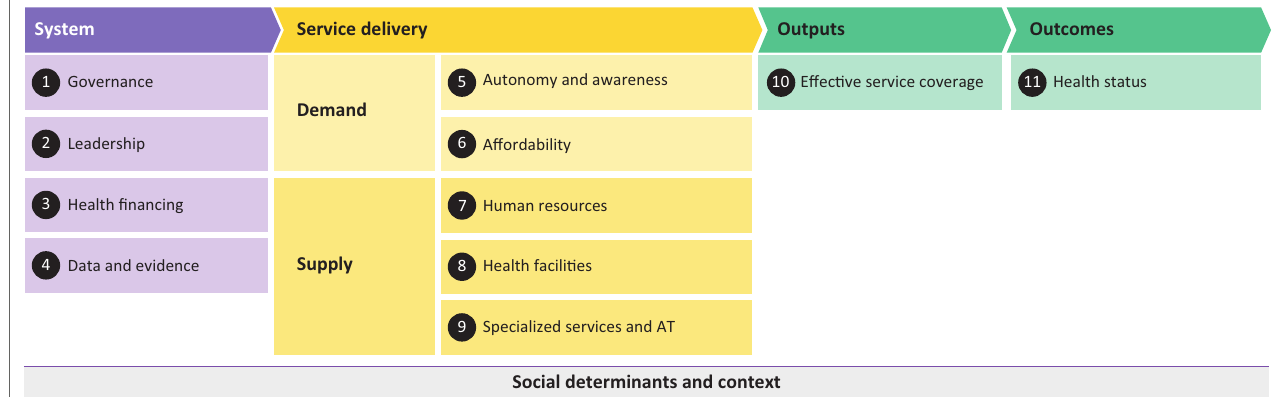
FIGURE 1: Preliminary framework of inclusive health